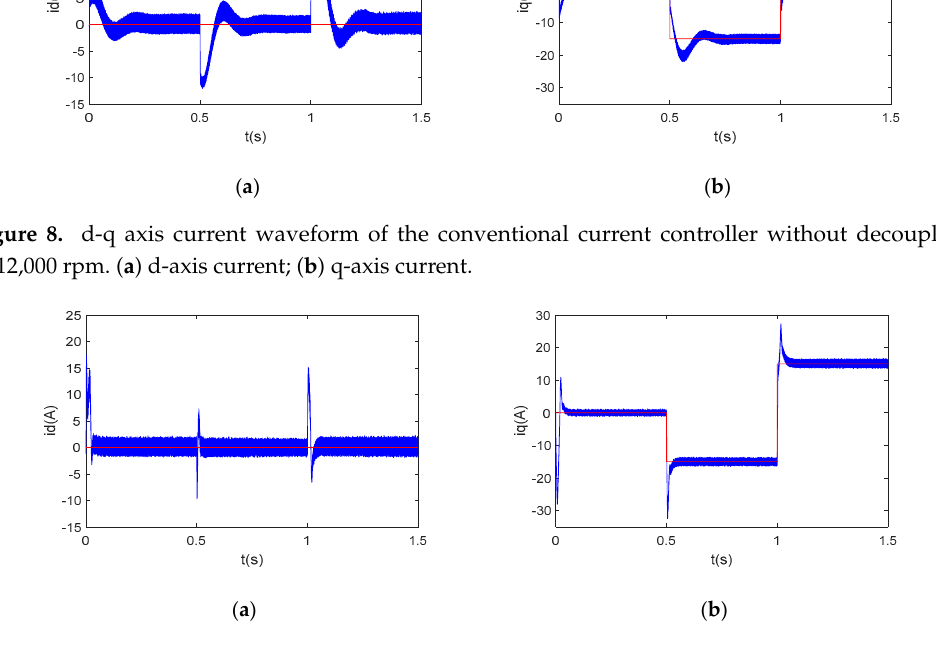
Figure 9. d-q axis current waveform of the conventional current controller with feedback decoupling at 12,000 rpm. ( a ) d-axis current; ( b ) q-axis current.